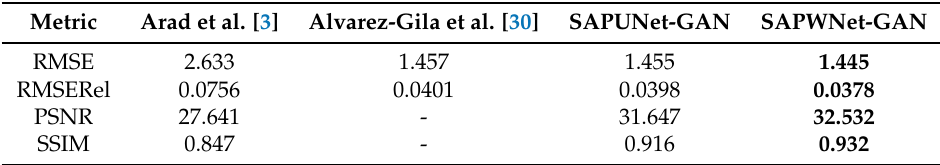
Table 2. A summary of the results of the conducted experiments including RMSE, RMSERel, PSNR and SSIM over the ICVL dataset